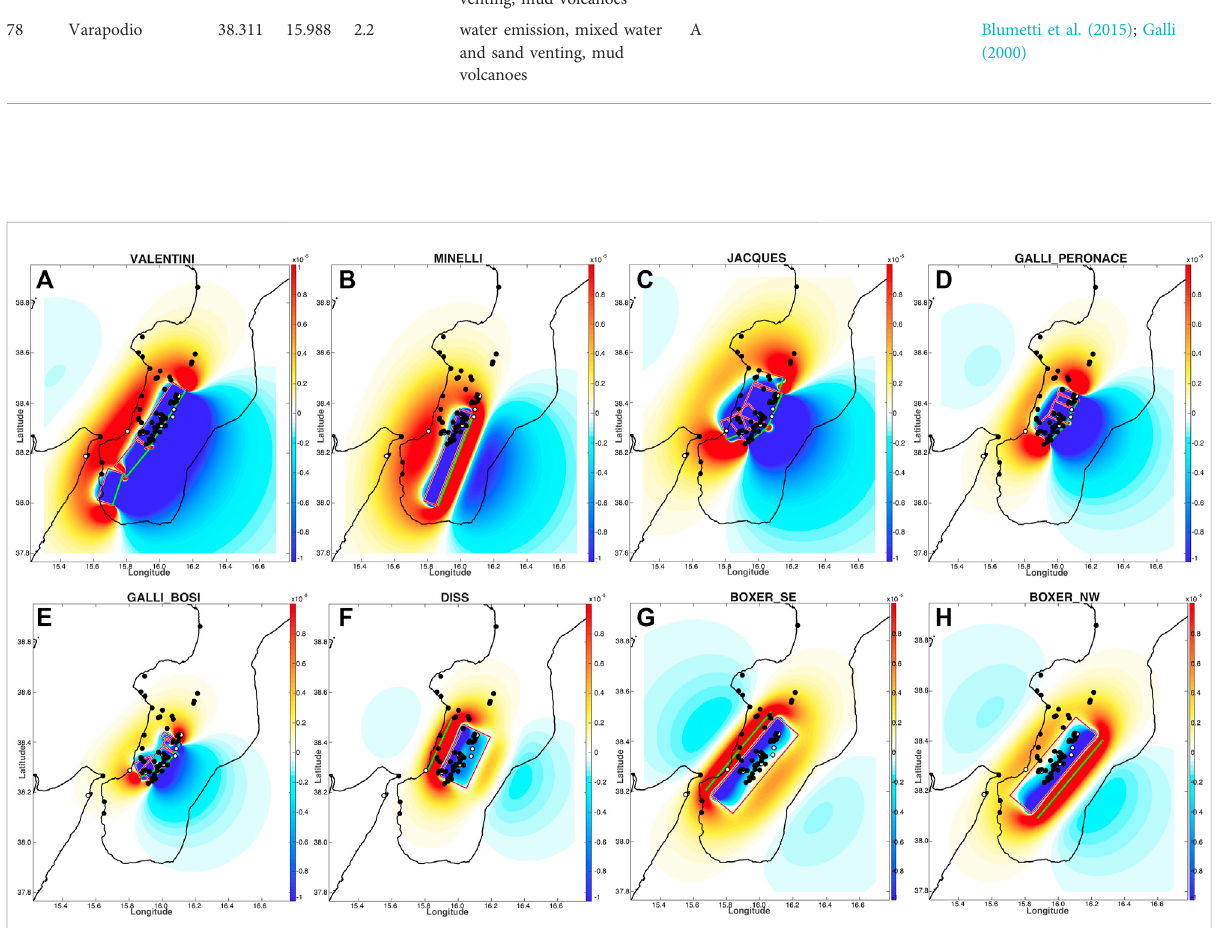
FIGURE 7 Comparisonbetweenthecalculatedcoseismicstrain fi eldsalongeightpotentialsourcesandtheobservedhydrologicaleffectsproducesbythe 1783 earthquake. In the plots of strain, blue shading indicates areas in compression, and red shading areas in dilatation. The input parameters of the Coulomb 3.4 code are: Poission ’ s ratio 0.25; Young ’ s modulus 8 x 10 5 bars; friction coef fi cient 0.4; shear modulus 3.3 x 10 5 bars. For the output the dilatational strain is assumed positive. Units: 10 -5 . A red rectangle indicates the surface projection of the fault plane; a green line is the intersection of the updip projection of the fault with the surface. Stream fl ow changes are indicated by circles (black/discharge increase; white/ discharge decrease). An increase in discharge is expected in compressional areas, and a stream fl ow decrease in dilatational